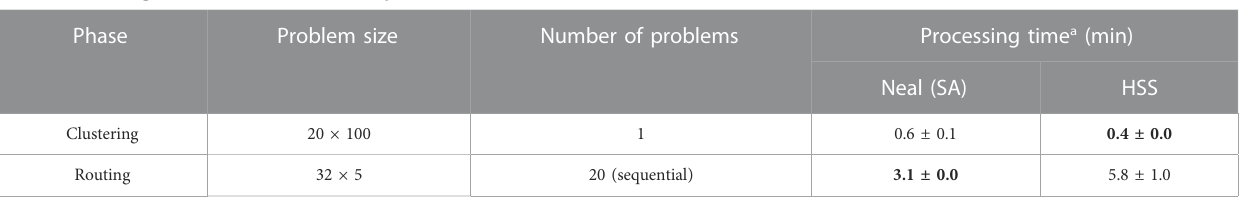
TABLE 7 Energetic advantage of each solver in the clustering phase. Phase